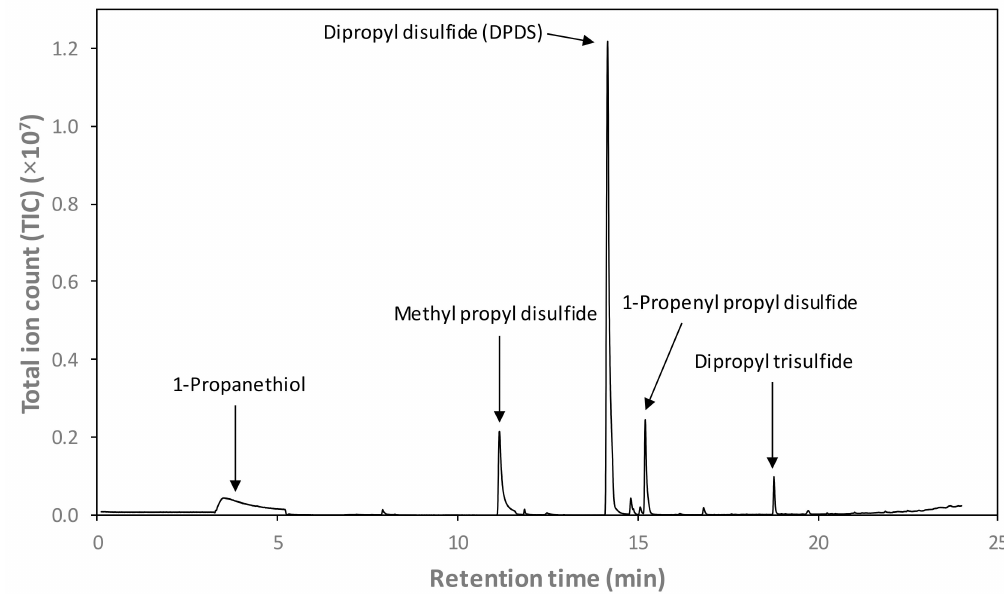
Figure 6. Total ion chromatogram of the headspace of the sodium phosphate bu ff er (0.01 M, pH 7) following 6 h of steeping with a PEF-treated onion bulb, obtained using solid-phase microextraction gas chromatography–mass spectrometry (SPME-GC-MS). Target peaks of interest are identified and labelled. Note that 1-propanethiol co-eluted with the broad air peak ( ≈ 3.2–5.2 min), quantified with an extracted ion ( m / z 76).